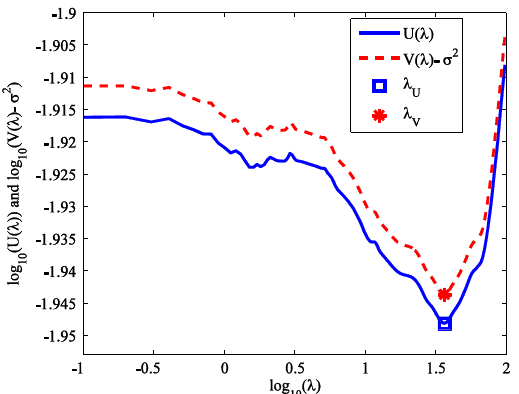
Figure 1. Stein’s unbiased risk estimator (SURE) and general cross-validation (GCV)- σ 2 versus λ in logarithmic scale.